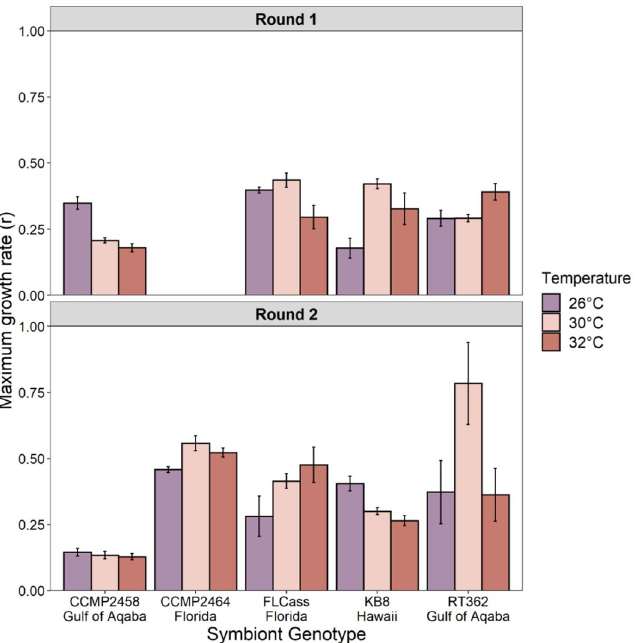
Figure 3. Mean maximum growth rate (+ SE) of symbiont genotypes measured in vitro at three experimental temperatures during each experimental round. CCMP2464 did not grow during Round